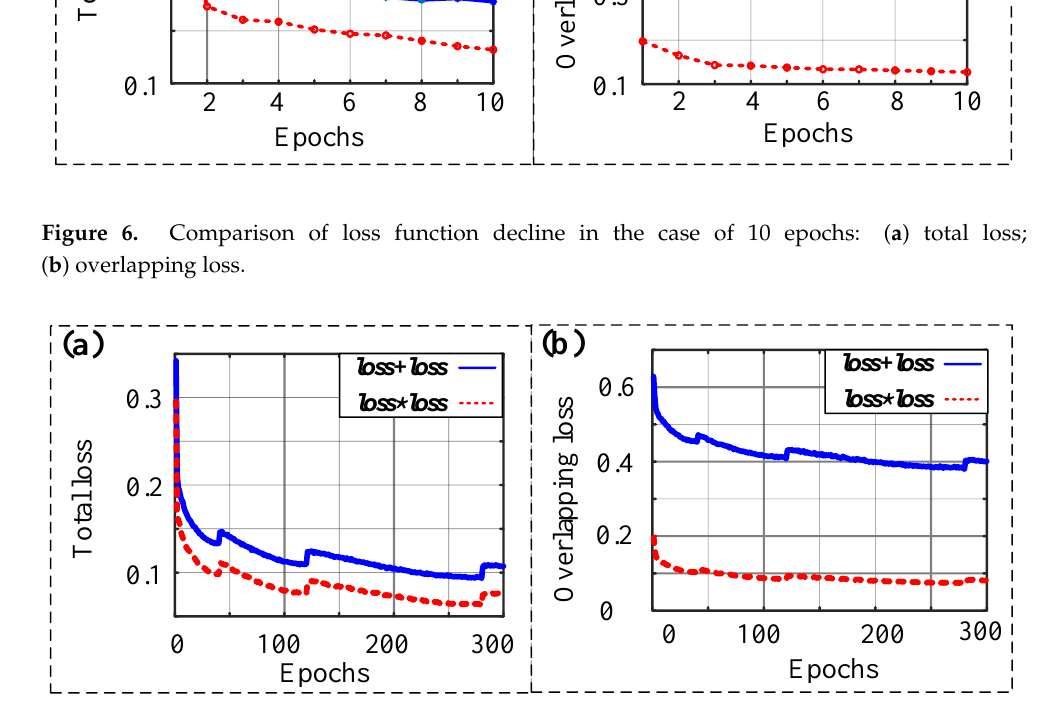
Figure 7. Comparison of loss function decline in the case of 300 epochs: ( a ) total loss; ( b ) overlapping